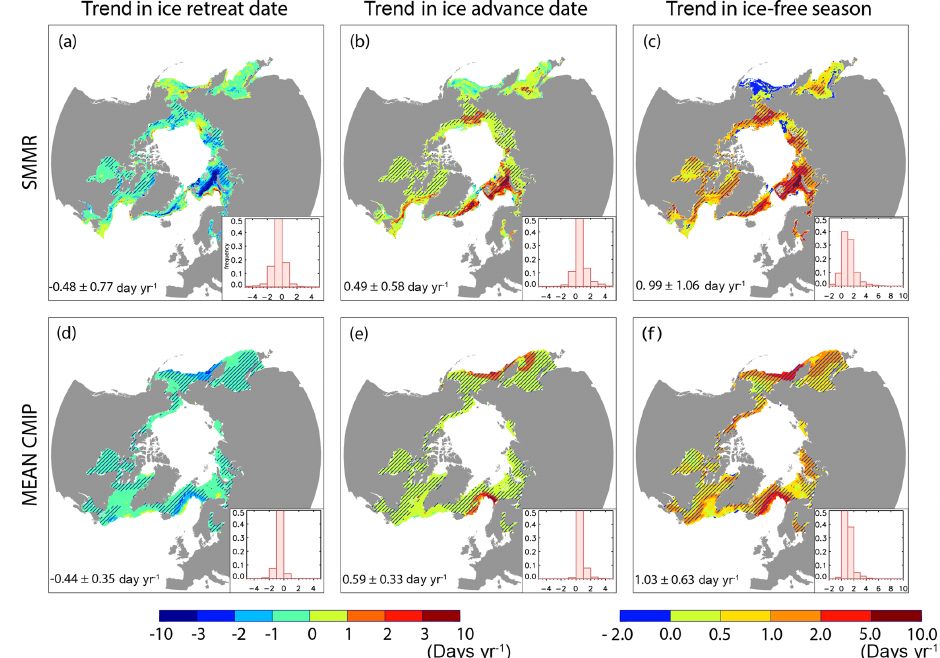
Figure 3. Maps and frequency histograms of linear trends (for hatched zones only) in (a, d) ice retreat date (b, e) , ice advance date and (c, f) ice-free season length over 1980–2015 (36 years), based on (a, b, c) passive microwave satellite concentration retrievals (Comiso, 2000; updated 2015); (d, e, f) the mean CMIP5 models. Hatching refers to the 95% confidence interval ( p = 0 . 05). Median ± IQR refers to significant pixels with at least one-third of the years with defined retreat and ice advance dates. See Fig. S4 for individual